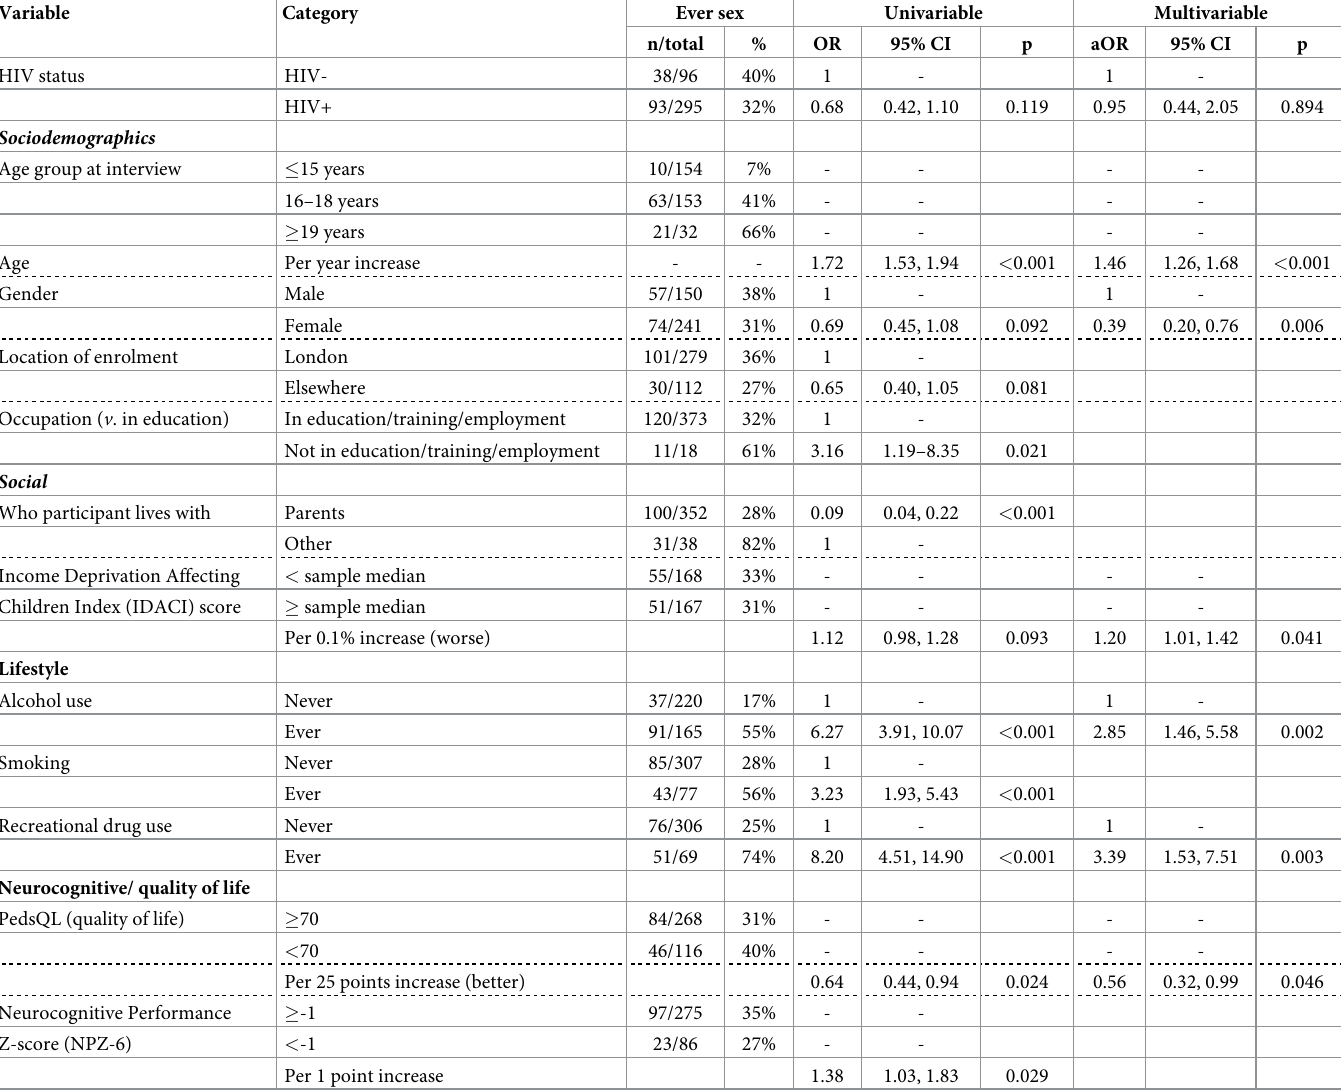
Table 4. Prevalence, and univariable and multivariable predictors of ever having vaginal and/or anal